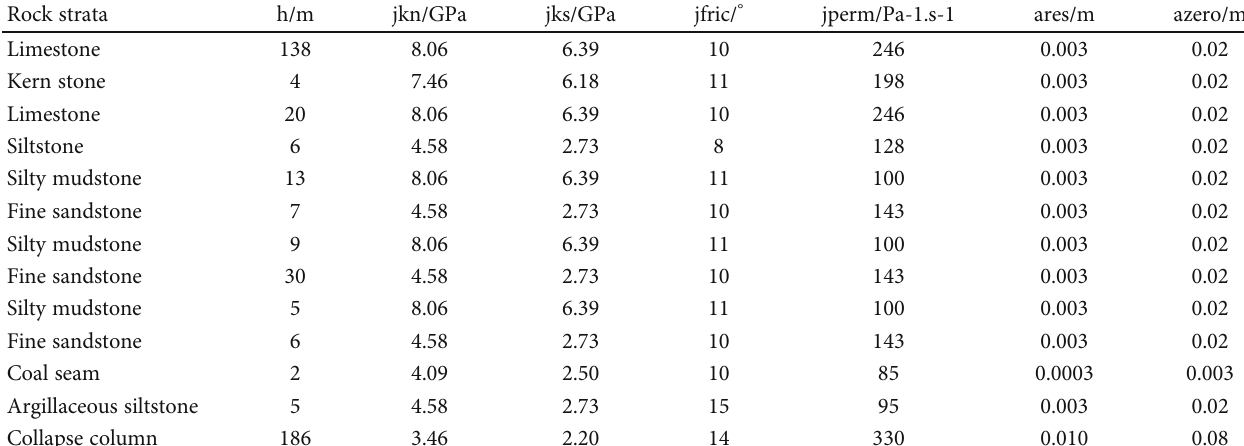
Table 2: The percolation mechanical parameters of joints.